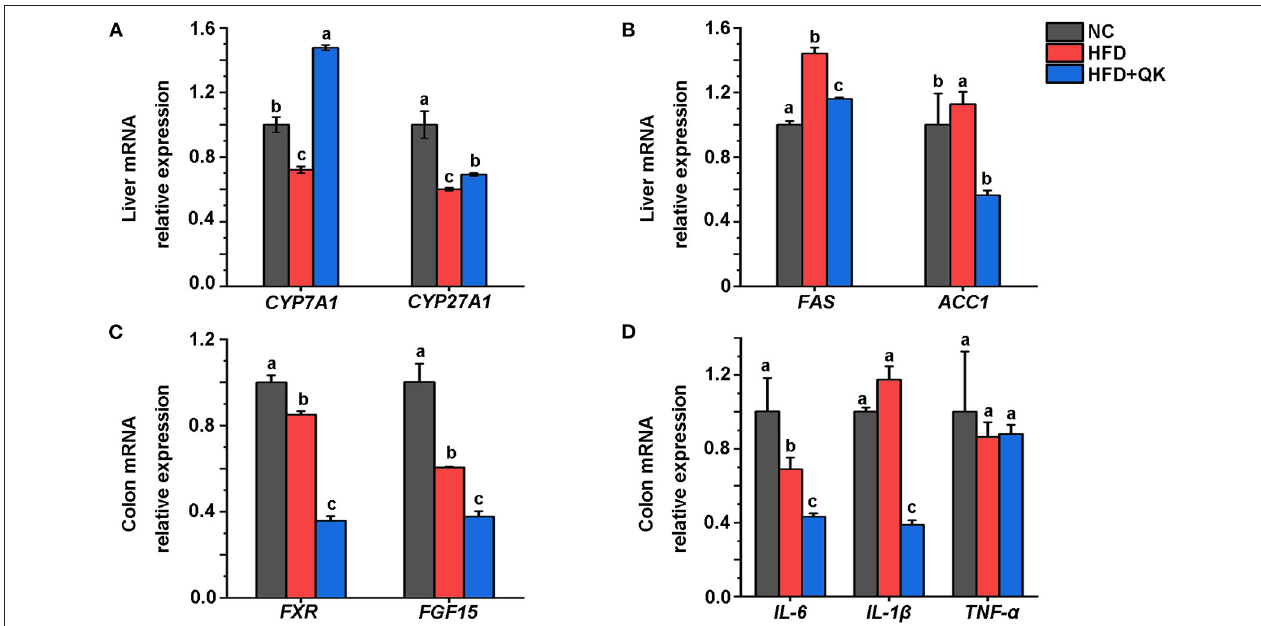
FIGURE 9 | WGQK affects the liver lipid metabolism and intestinal function. (A) Relative mRNA expression of BA synthesis genes CYP7A1 and CYP27A in the liver, (B) Relative mRNA expression of Lipogenesis genes FAS and ACC1 in the liver; (C) Relative mRNA expression of FXR and FGF15 in the colon, (D) Expression of three inflammation genes in the colon. Data are presented as mean ± SD ( n = 3), significant difference was determined using an unpaired two-tailed t -test, different superscript letters of any two means represent significant differences ( p <